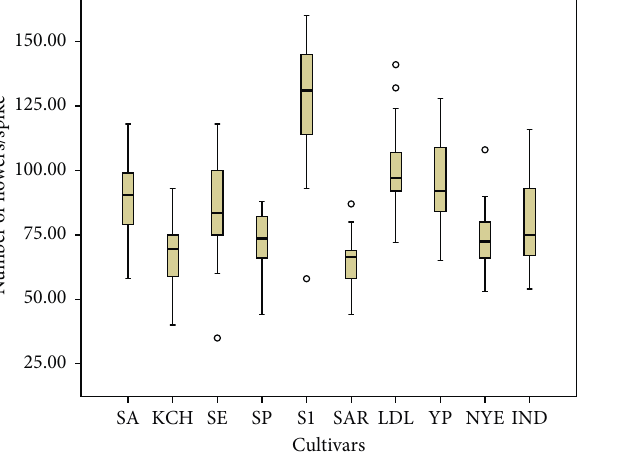
Figure 7: Number of flowers per inflorescence.